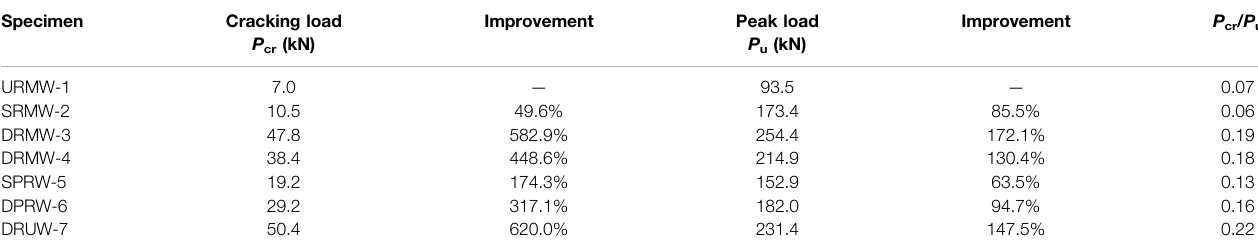
TABLE 4 | Critical load values of the specimens.